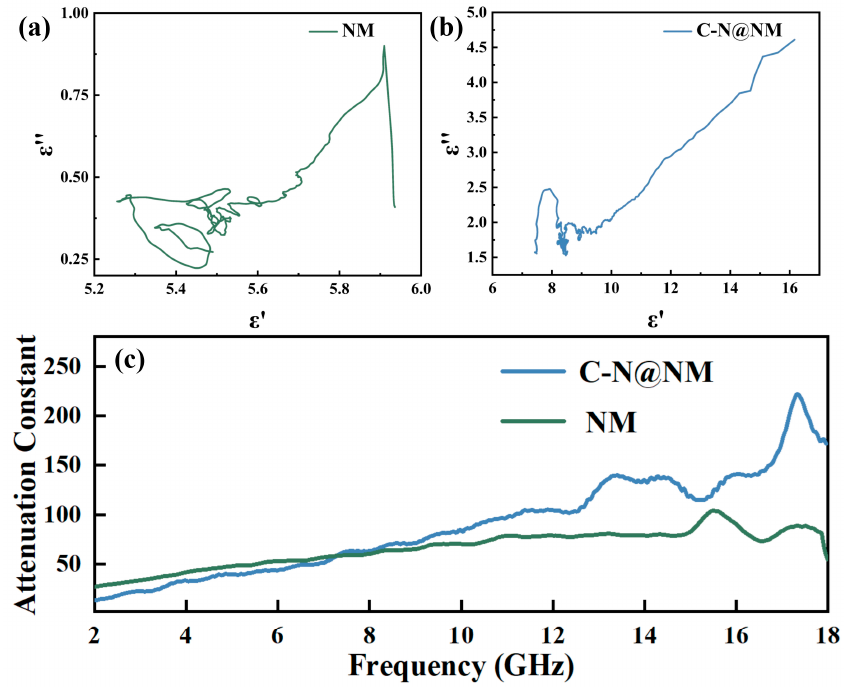
Figure 6. Cole–Cole plots: ( a ) NM; ( b ) C-N@NM; ( c ) Attenuation constants ( α ) of NM and C-N@NM.